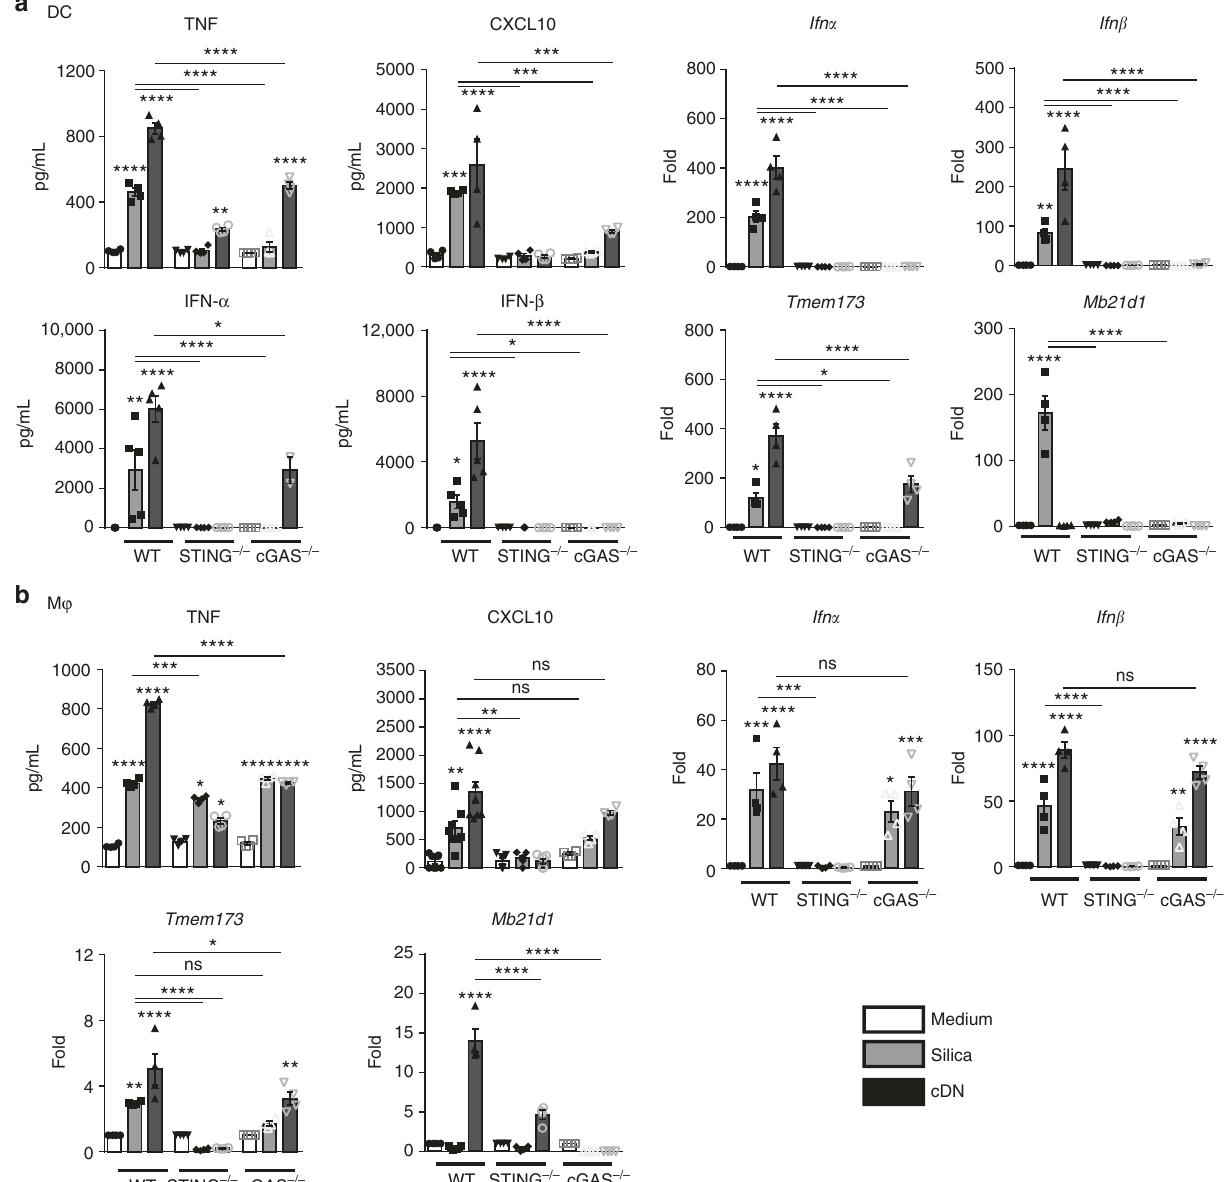
Fig. 8 Different cGAS requirement for silica-induced STING-dependent activation in macrophages and DCs. Bone marrow-derived DCs ( a ) or macrophages ( b ) from WT, STING − / − , and cGAS − / − were unstimulated, stimulated with silica (250 µ g/mL), or transfected with c-di-AMP (6 µ g/mL; cDN) for 18 h. a Levels of TNF and CXCL10 quanti fi ed by ELISA in DC supernatant. Ifn α , Ifn β , Tmem173 , and Mb21d1 transcripts measured by real-time PCR on DC cell fractions. IFN- α and IFN- β protein concentrations determined in the DC supernatant by multiplex immunoassay. b Levels of TNF and CXCL10 quanti fi ed by ELISA in macrophage supernatant. Ifn α , Ifn β , Tmem173 , and Mb21d1 transcripts measured by real-time PCR on macrophage cell fractions. ns p > 0.05 not signi fi cant, * p < 0.05, ** p < 0.01, *** p < 0.001, **** p < 0.0001 (Kruskal – Wallis test followed by Dunn post test). Data are presented as mean ± SEM ( n = 6) and are representative of two independent experiments. Source data are provided as a Source Data fi